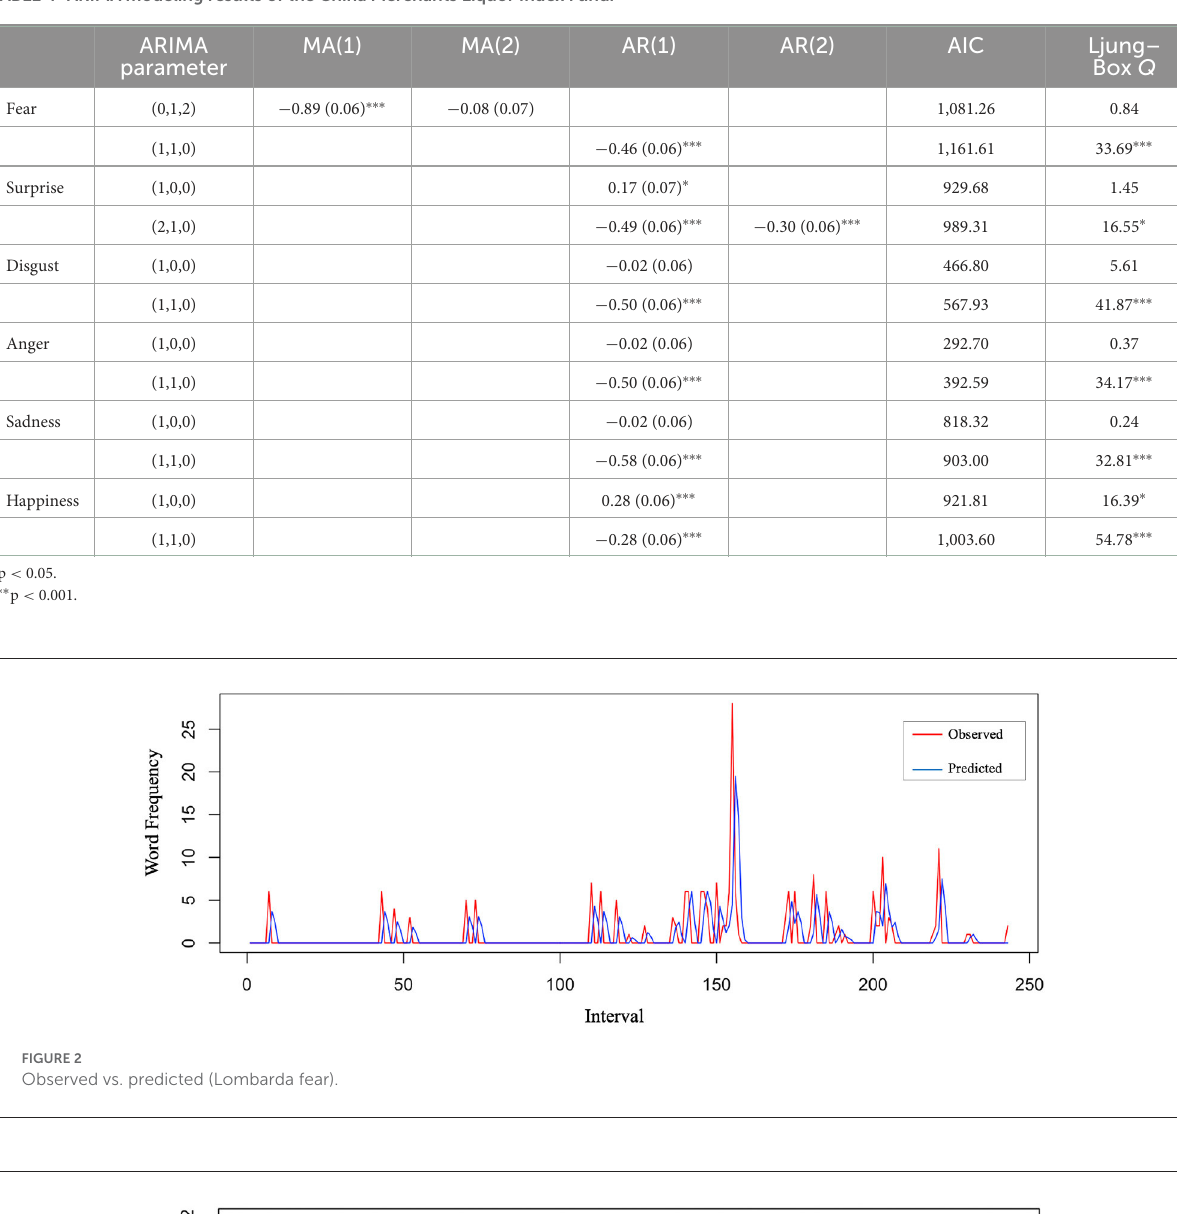
TABLE 4 ARIMA modeling results of the China Merchants Liquor Index Fund.